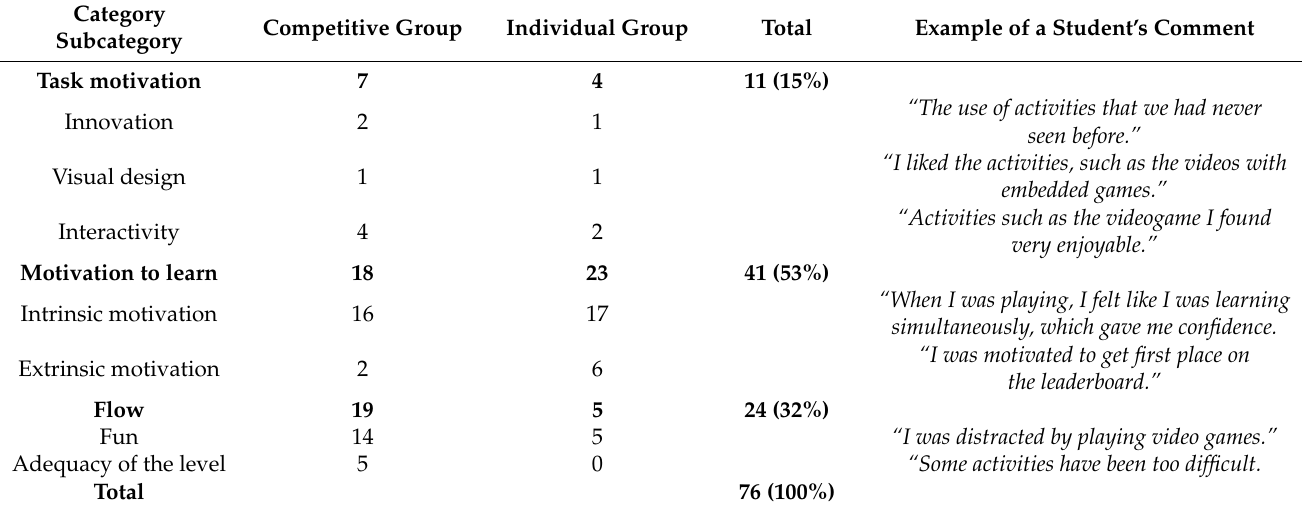
Table 4. Question 1. Comparison between competitive, individual gamifications and comment examples.